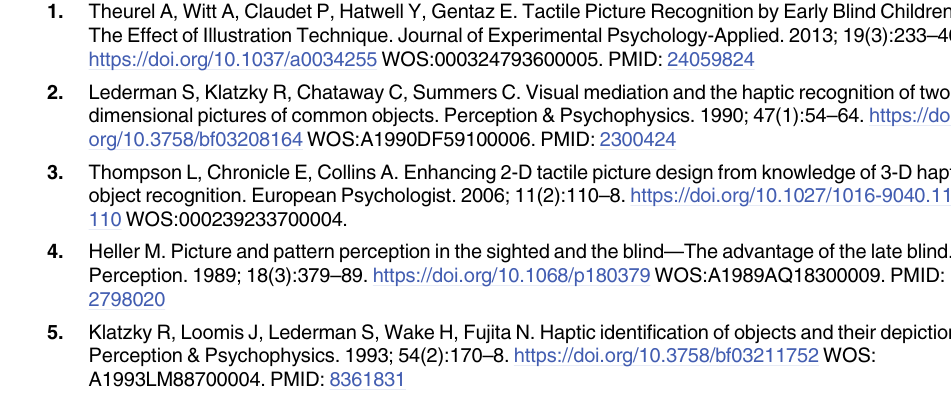
S1 Table. Appendix mean scores of contact frequency with action objects—Experiment 1. S2 Table. Data set Experiment 1. S3 Table. Data set Experiment